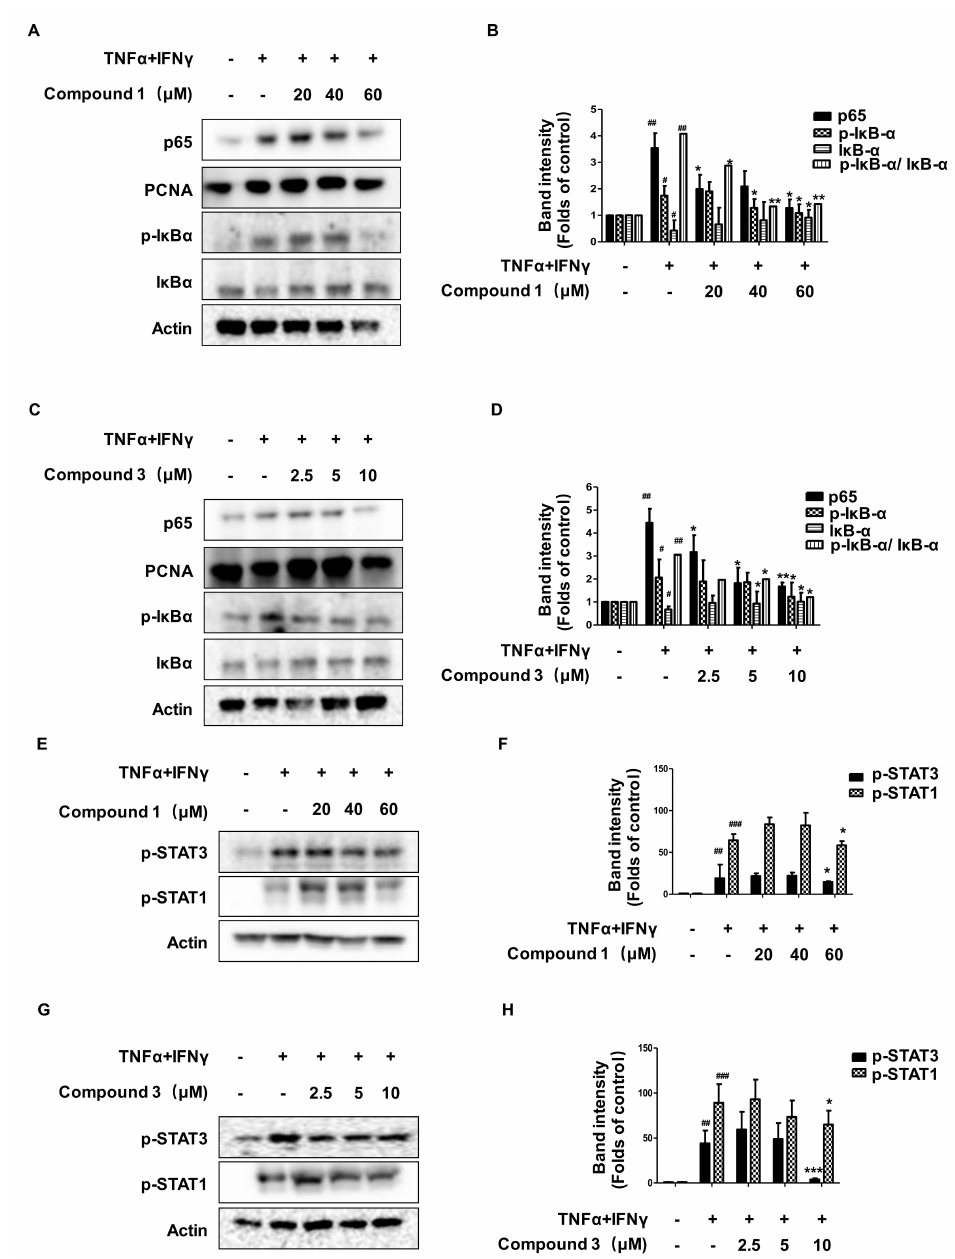
Figure 7. Effects of compounds 1 and 3 on the NF- κ B- ( A – D ), p-STAT1-, and p-STAT3- ( E – H ) signaling pathway in HaCaT cells. The cells were pre-treated with the indicated concentrations of compounds 1 and 3 for 3 h (+) or not (-), and then stimulated with TNF- α /IFN- γ (+) for 15 min. Cytosol and nuclear extracts were isolated, and levels of p65, p-I κ B α , and I κ B α in fractions were determined by Western blotting. The expression of p-stat3, p-stat1, and total proteins were measured using Western blotting. The bar graphs represent quantitative densities of the bands. Data are represented as the mean ± SD of three independent experiments. # p < 0.05, ## p < 0.01, ### p < 0.001 vs. control. * p < 0.05, ** p < 0.01, *** p < 0.001 vs. TNF- α /IFN- γ -treated